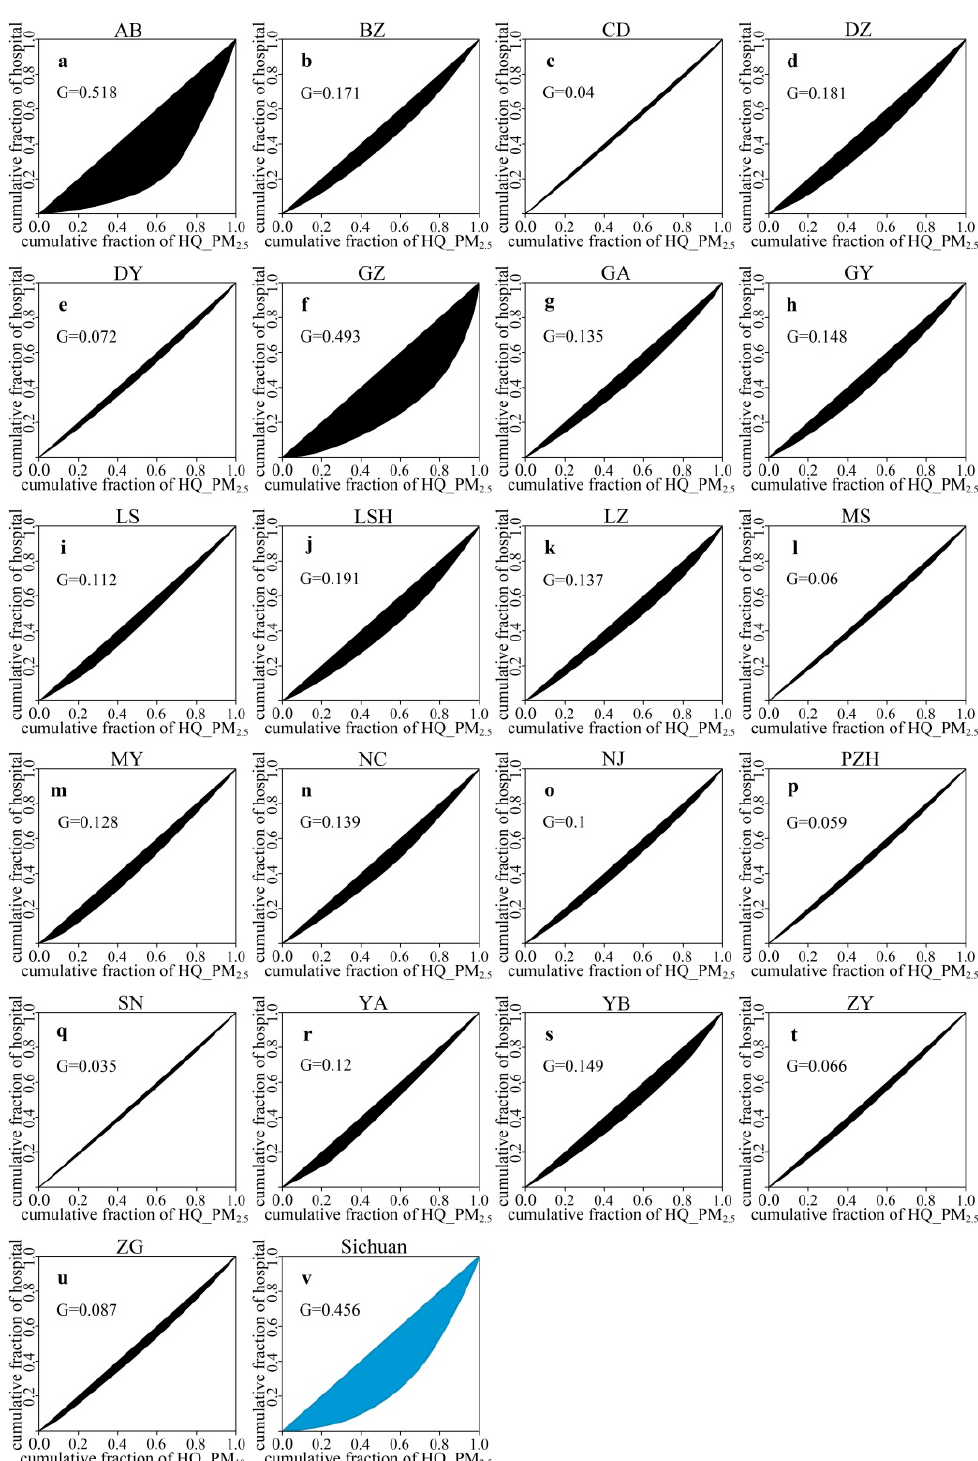
Figure 6. Spatial inequality analysis between the infant hazard quotient caused by PM 2.5 (HQ_PM 2.5 ) and hospital density: ( a ) Aba, ( b ) Bazhong, ( c ) Chengdu, ( d ) Dazhou, ( e ) Deyang, ( f ) Ganzi, ( g ) Guangan, ( h ) Guangyuan, ( i ) Leshan, ( j ) Liangshan, ( k ) Luzhou, ( l ) Meishan, ( m ) Mianyang, ( n ) Nanchong, ( o ) Neijiang, ( p ) Panzhihua, ( q ) Suining, ( r ) Yaan, ( s ) Yibin, ( t ) Ziyang, ( u ) Zigong, and ( v ) Sichuan.